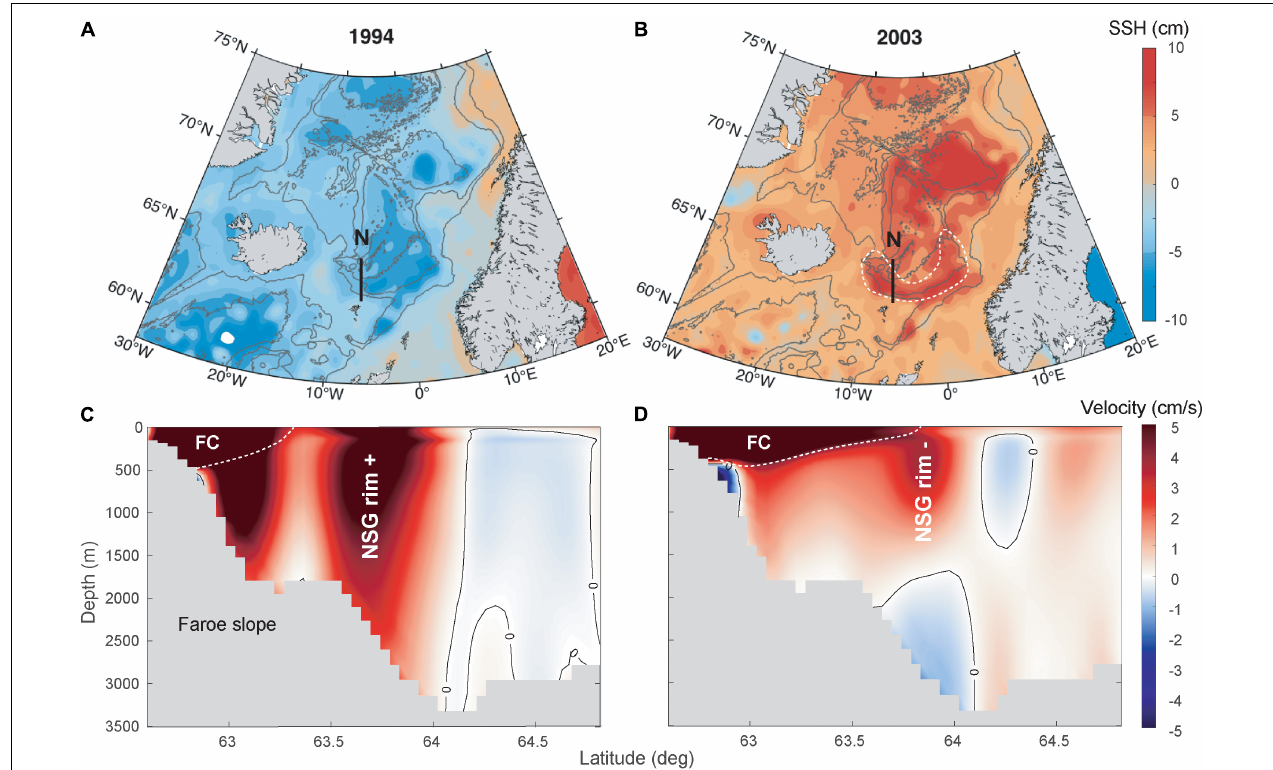
FIGURE 2 | Contrasting states of the NAO and the Norwegian Sea Gyre. Left panels show a NAO + /NSG rim + state (year 1994) and the right a NAO − /NSG rim − state (year 2003). The upper panels show annually averaged SSH anomalies (deseasonalized and detrended satellite altimetry data) and the lower panels show annually averaged simulated eastward current velocities through Section N (black lines in A,B ). The approximate position of the interface (dashed white curves in C,D ) marks the lower boundary of the Faroe Current (FC). The horseshoe-shaped band is illustrated in (B) with the dashed white